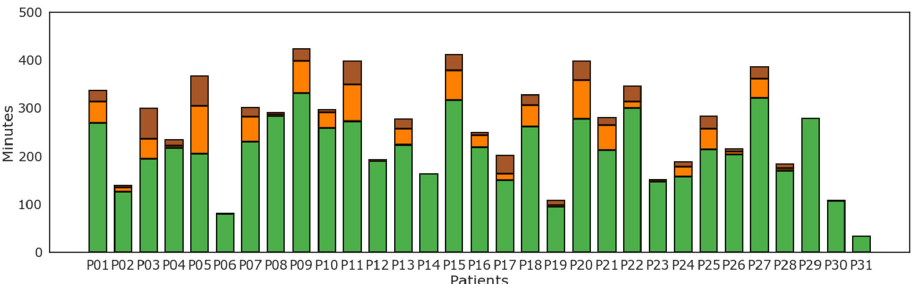
Figure 5. Minutes of physical activity according to level of intensity of physical activity: lightly active (green), moderately active (orange), and very active (brown) minutes for each patient (P01–P31).